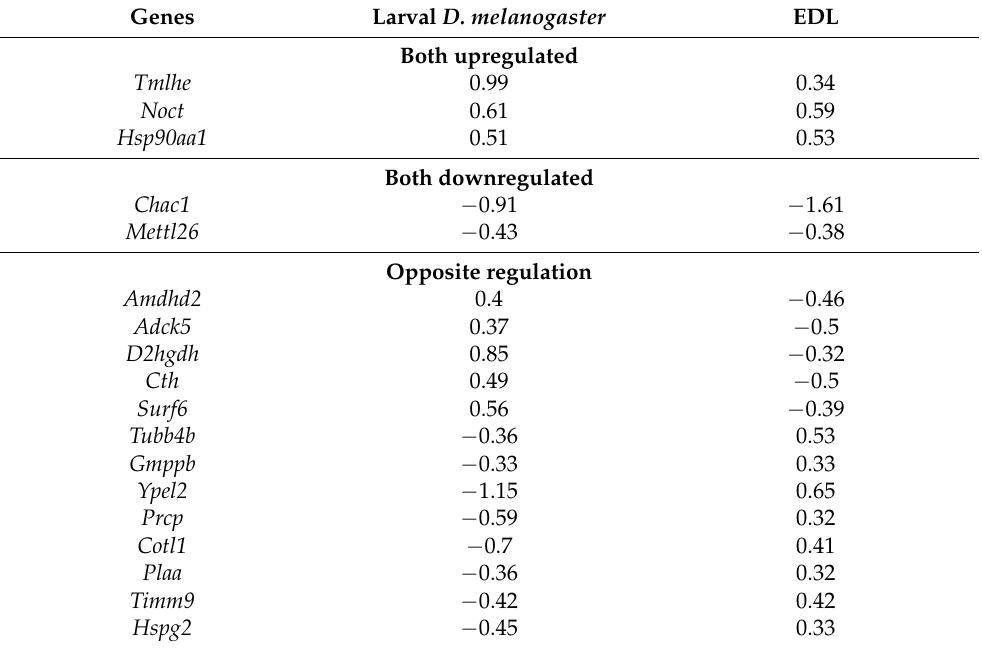
Table 3. DEGs shared between space flown D. melanogaster and EDL and their direction of regulation. Values shown are Log2 FC. Genes Larval D. melanogaster